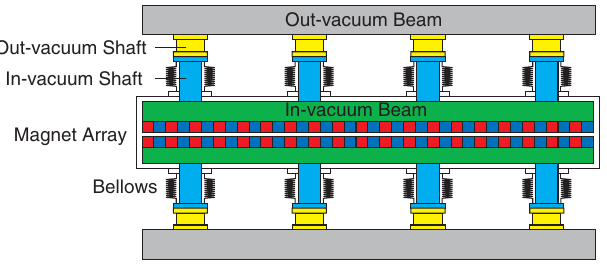
FIG. 1. (Color) Schematic illustration of the structure of an IVU.